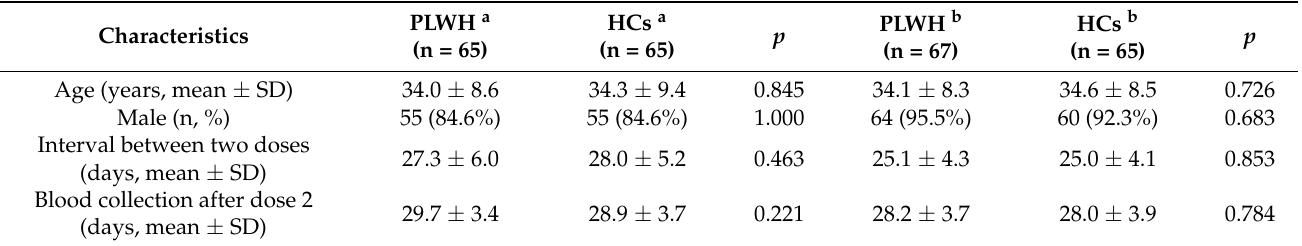
Table 2. PLWH and HCs’ characteristics of first blood collection after two doses of BBIBP-CorV vaccine or CoronaVac vaccine (N =